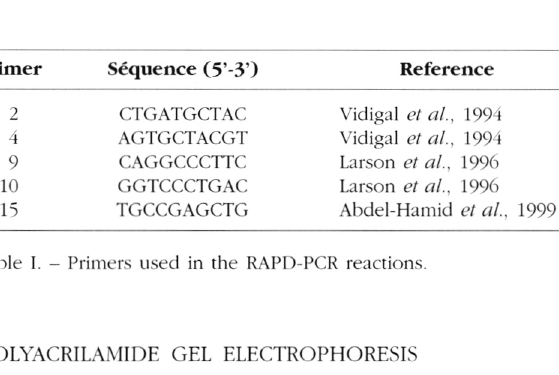
POLYACRILAMIDE GEL ELECTROPHORESIS